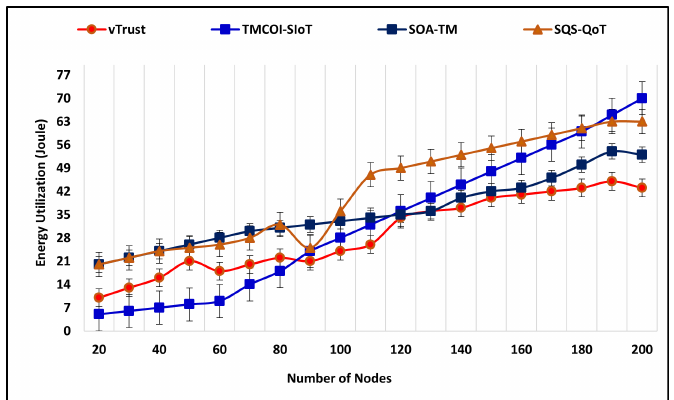
Figure 9. Average energy consumed to compute